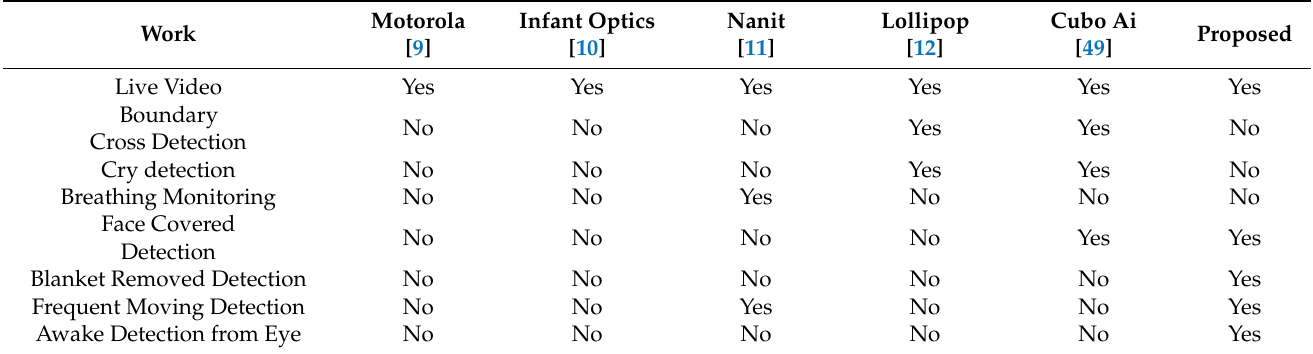
Table 2. Comparison with other